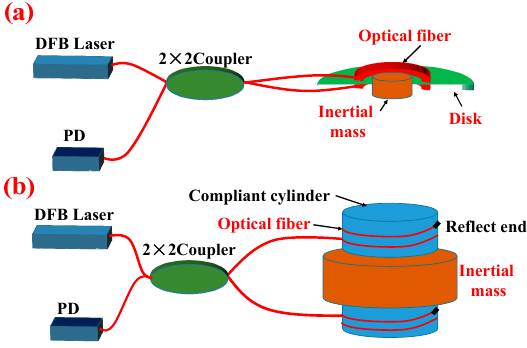
Figure 5. Two types of optical fiber interference vibration detector based on Michelson interferometer. ( a ) Disk type Michelson interferometer; ( b ) Compliant cylinder type Michelson interferometer.